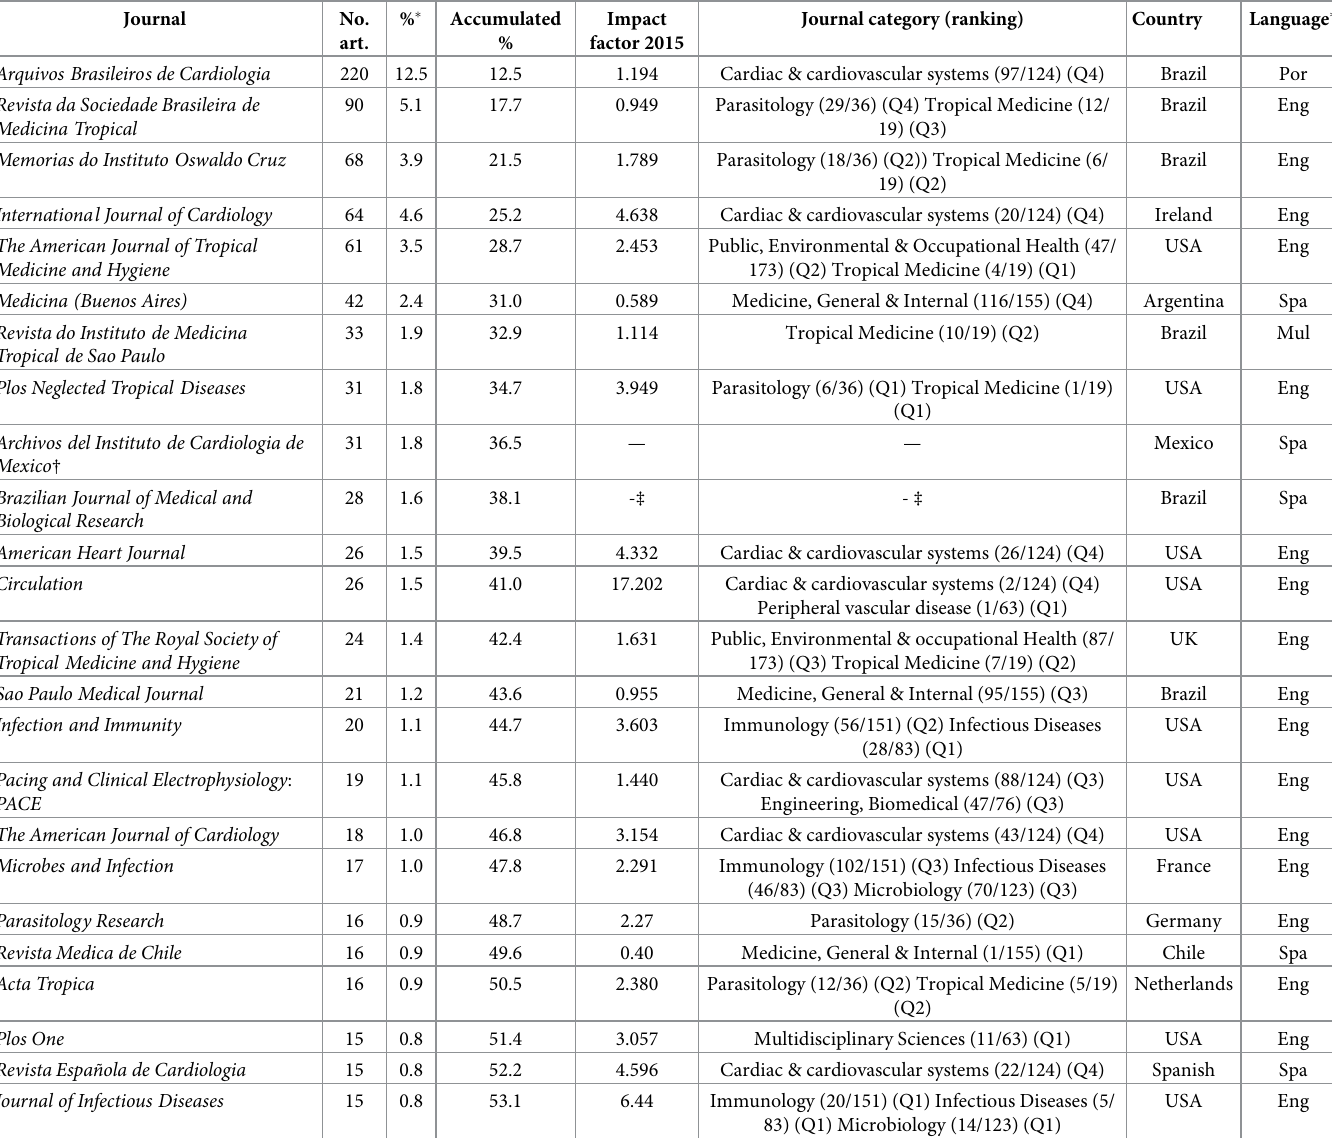
Table 2. The 24 journals publishing the most reports on Chagas cardiomyopathy, their impact factor, subject category and ranking in the 2015 Journal Citation Reports ;and their country and language of publication.